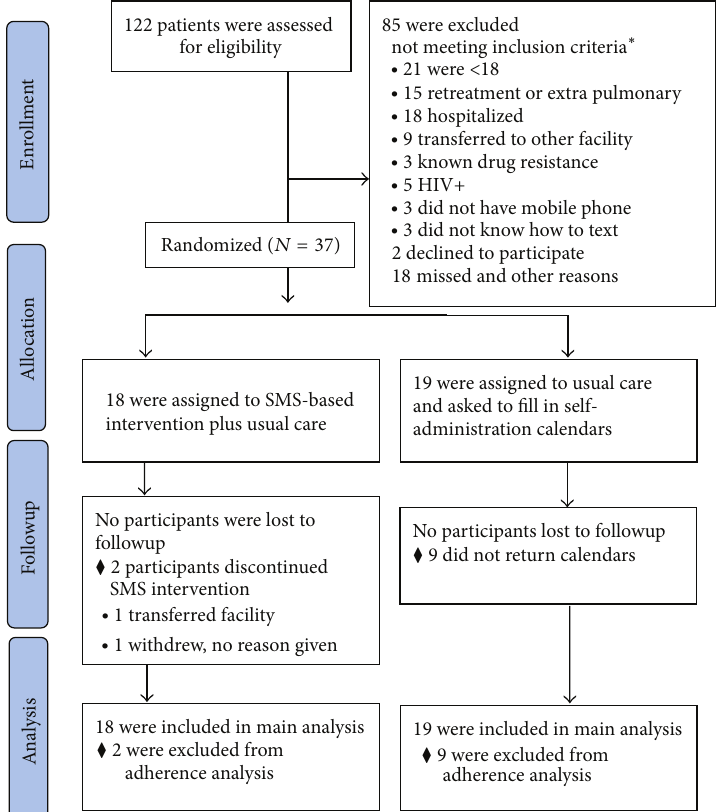
Figure 1: Patient flow diagram ∗ numbers do not sum to 100% because multiple criteria can apply for an individual.